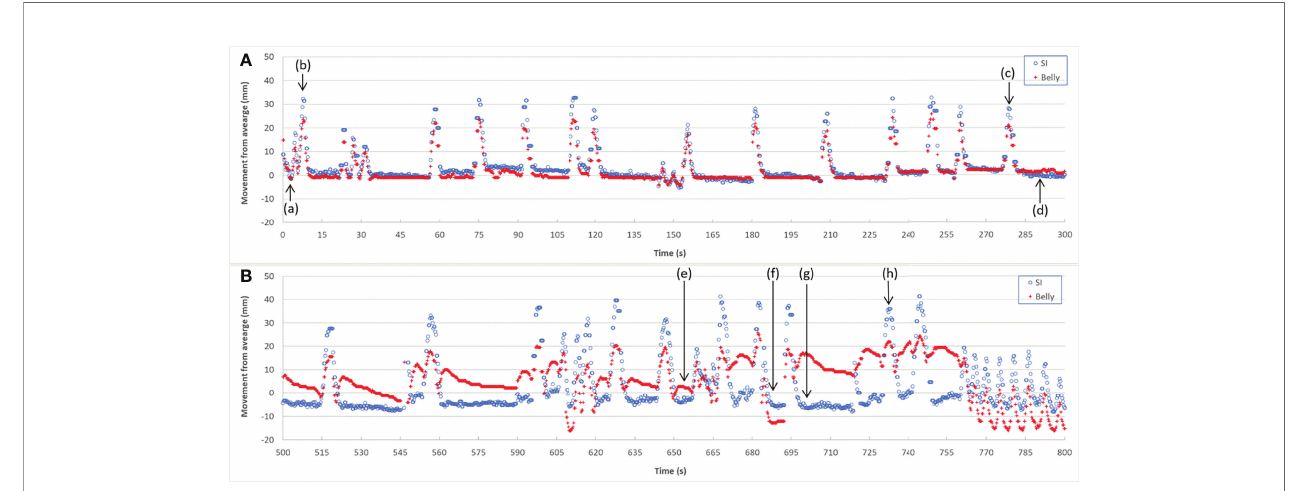
FIGURE 4 | Target SI and Belly motion as functions of time for Session #3 (A) and Session #4 (B) of patient LV13.